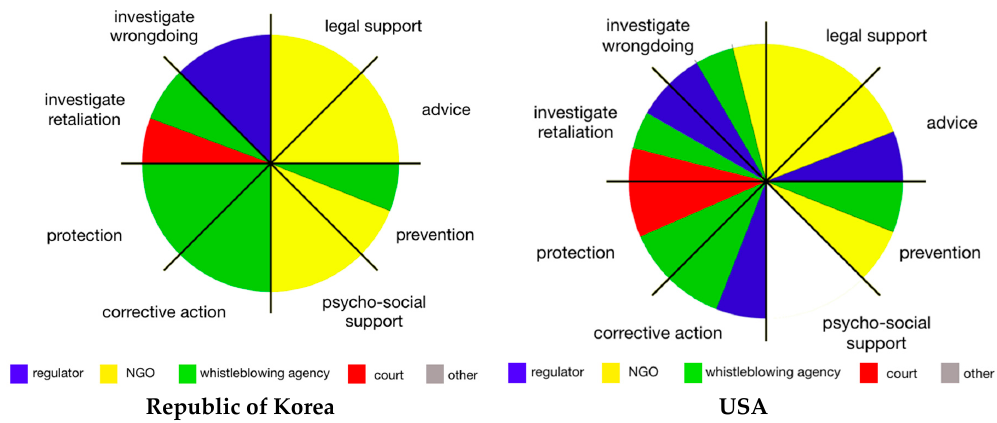
Figure 1. Various tasks of governmental whistleblowing agencies in this study.